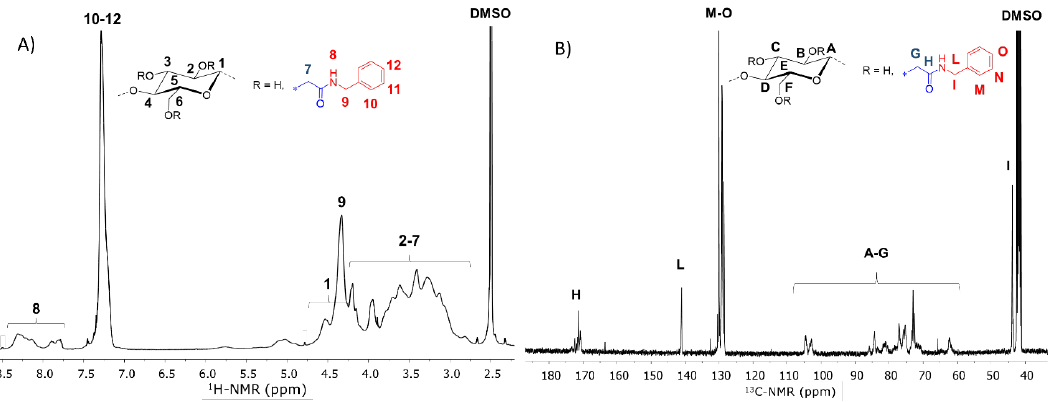
Figure 4. 1 H- ( A ) and 13 C-NMR ( B ) of CMC-Benz (Table 1, Entry 3), in DMSO-d6 and at 358 K. The analyses of 1 H– 13 C heteronuclear single quantum coherence (HSQC), used to determine proton-carbon single bond ( 1 J) correlations, and heteronuclear multiple bond correlation (HMBC), highlighting long-range ( 2 J- 3 J) correlations between 1 H and 13 C nuclei, were employed to confirm the assignments of the substituent signals. HSQC analysis (Figure 5A) corroborates the chemical shifts of proton and carbon signals of the grafted moieties, by showing a direct correlation between protons 9 and 10–12 with the corresponding carbons I and M–O. The HMBC experiment (Figure 5B) not only further supports the assignments but allows for proving the covalent coupling through the multiple- bond correlation between benzyl CH 2 (9) and the adjacent carbonyl of the amide (H).